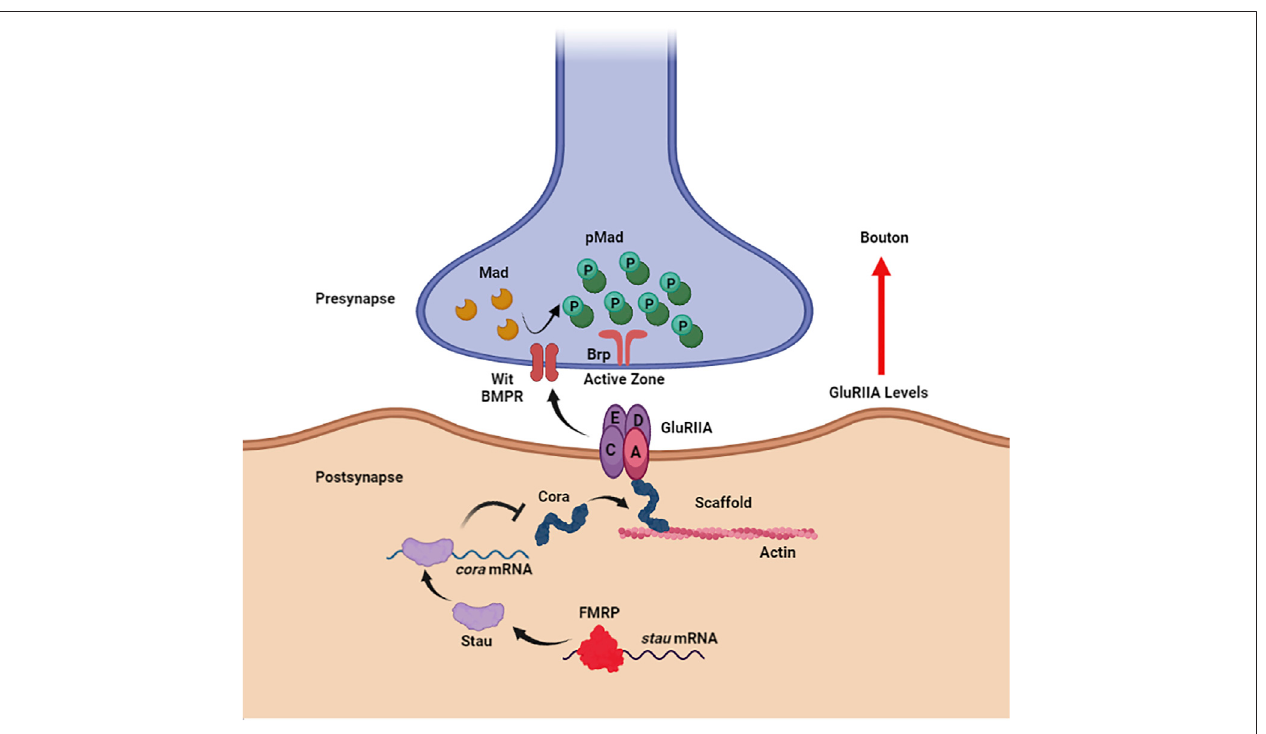
FIGURE1| NoncanonicalBMPsignalingisrestrictedbyFMRPtolimitsynaptogenesis. Inthe Drosophila larvalneuromuscularjunctionpostsynapticcompartment (bottom), FMRP directly binds to staufen ( stau ) mRNA to promote translation. Staufen, in turn, binds coracle ( cora ) mRNA to inhibit translation. Coracle acts as an actin scaffold to anchor the glutamate receptor type II A (GluRIIA) opposing the presynaptic active zone scaffolded by Bruchpilot (Brp). GluRIIA accumulation induced by loss of postsynaptic FMRP activates noncanonical, trans -synaptic signaling via the BMP receptor (BMPR) Wishful Thinking (Wit) to drive Mad phosphorylation (pMad) around presynaptic active zones, resulting in synaptic bouton formation. Figure created with BioRender (BioRender.com).